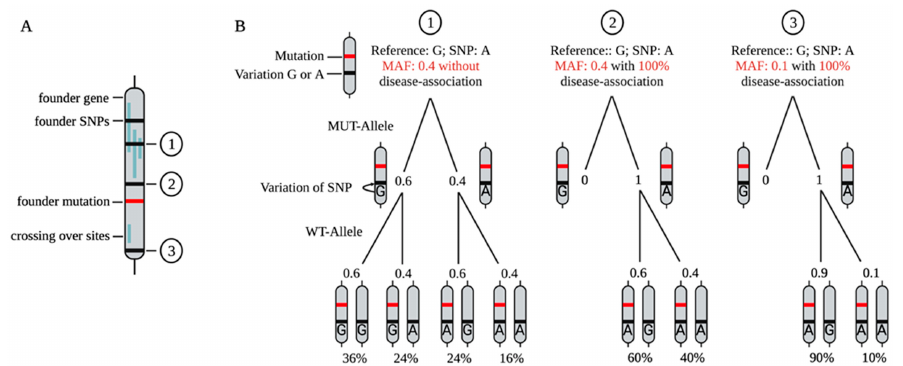
Figure 3. Schematic description of the association between the mutation site and non-disease-causing SNPs. ( A ) Exemplary representation of a gene with its founder mutation (red) and individual additional variants/SNPs (black). Vertical blue shadings exemplarily indicate common crossover sites. The more crossovers occur within a region, the less the association between different regions of the gene, and the linkage disequilibrium (LD) decreases. ( B ) Numbers 1, 2, and 3 show potential SNPs in the founder gene with different association strengths to the mutation site after some generations. SNP 1 has a MAF of 0.4 and is located within a region with several common crossover sites. Therefore, the SNP shows no association to the founder mutation, even though the founder gene carries SNP 1. In a patient cohort, SNP 1 is therefore similarly distributed to a control cohort. A total of 60% of the patients carry a G in SNP 1 on the same allele as the founder mutation, and 40% carry an A. The WT allele of the patients show the same distribution in SNP 1. With an ASO that specifically targets SNP 1_A, 24% of the cohort (A/G) could be treated as allele-specifical, and an additional 16% (A/A) as non-allele-specific. SNP 2 has a MAF of 0.4 but is 100% associated with the disease mutation. Therefore, every patient carries an A in SNP 2, along with the mutation on the MUT allele. With an ASO that targets SNP 2_A, 60% of the patients (A/G) could be treated as allele-specific and 40% as non-allele-specific. SNP 3 appears rarely in a population with an MAF of 0.1, but has an association of 100% to the mutation site. Every patient carries an A in SNP 3 on the same allele as the disease mutation. With an ASO that targets SNP 3_A, 90% of the patients (A/G) can be treated as allele-specific, and the remaining 10% as non-allele-specific. These example pedigrees show the importance of long coding sequencing of the whole genes of patient cohorts. Targeting rare SNPs that have a high disease association might be an optimal target. Identification of these rare, disease-associated SNPs reduces the number of ASOs needed to identify suitable ASOs for an allele-specific approach in a whole patient cohort. MAF = minor allele frequency; SNP = single nucleotide